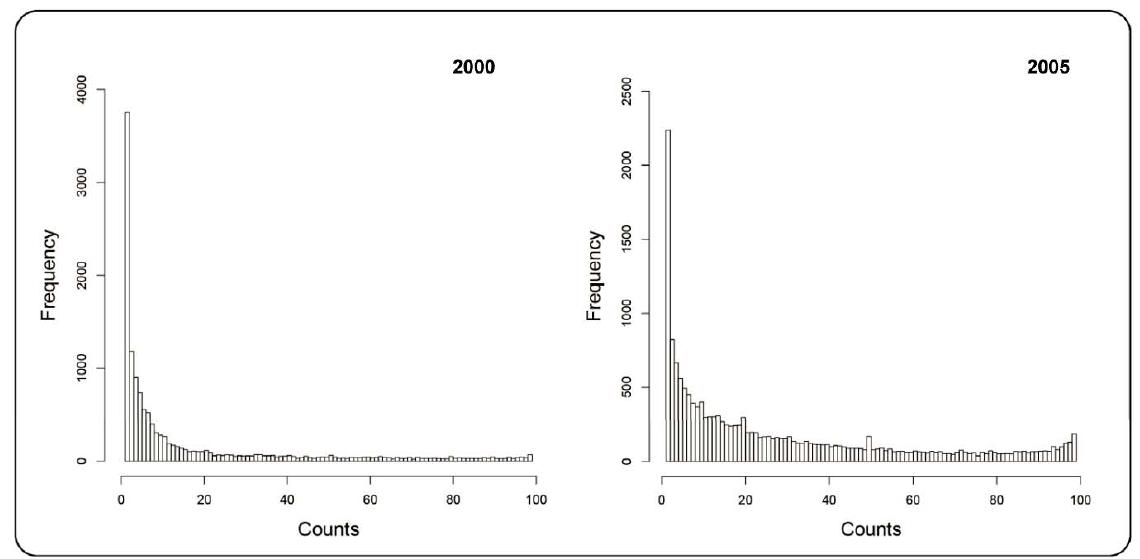
Figure 6. Frequency of 1 km cells containing a specific number of 1 ha cells in which mountain pine beetle are present for the years 2000 (left) and 2005 (right). Note that for 2005, Counts = 100 — the number of 1 ha cells occupied by mountain pine beetle.